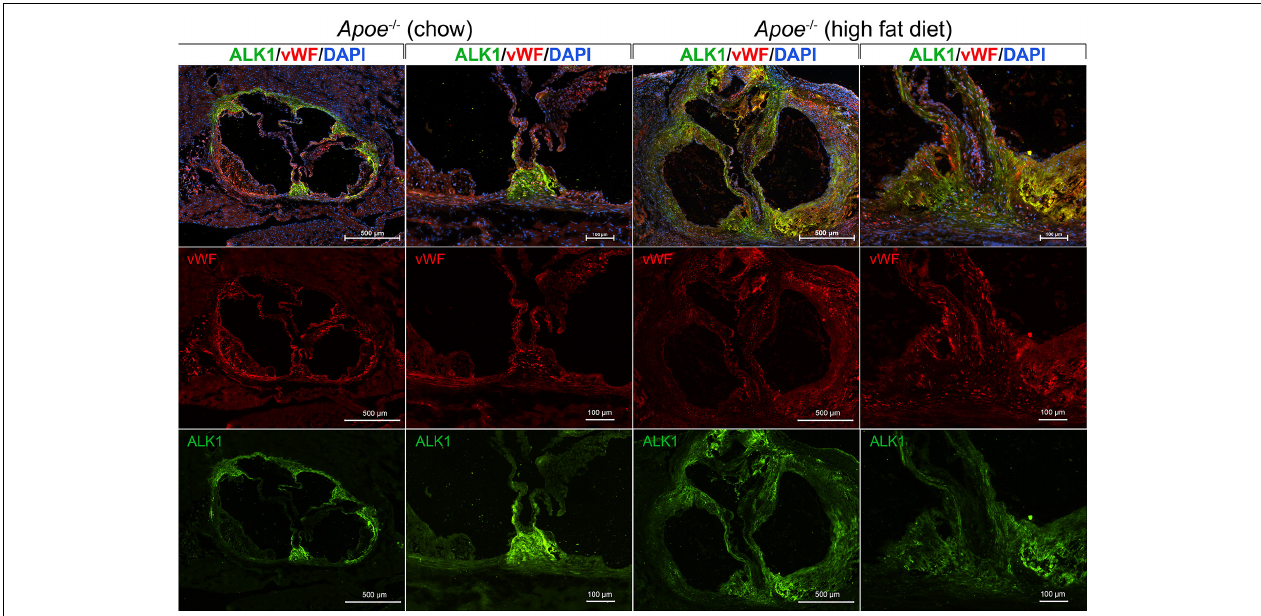
FIGURE 3 | ALK1, a receptor for BMP9, is induced in the aorta and aortic valves of Apoe − / − mice fed a high fat diet. Apoe − / − mice were fed regular chow or high fat diet for 6 weeks. Histological sections were prepared from the proximal aorta that included the aortic valves. The sections were stained for activin receptor-like kinase 1 (ALK1; green fluorescence) and von Willebrand factor (vWF; red fluorescence). DAPI was used for visualization of nuclei. The results showed a widespread induction of ALK1 in the thickened valves and aortic wall in the fat-fed Apoe − / − mice, which would allow for enhanced BMP9 osteoinduction.